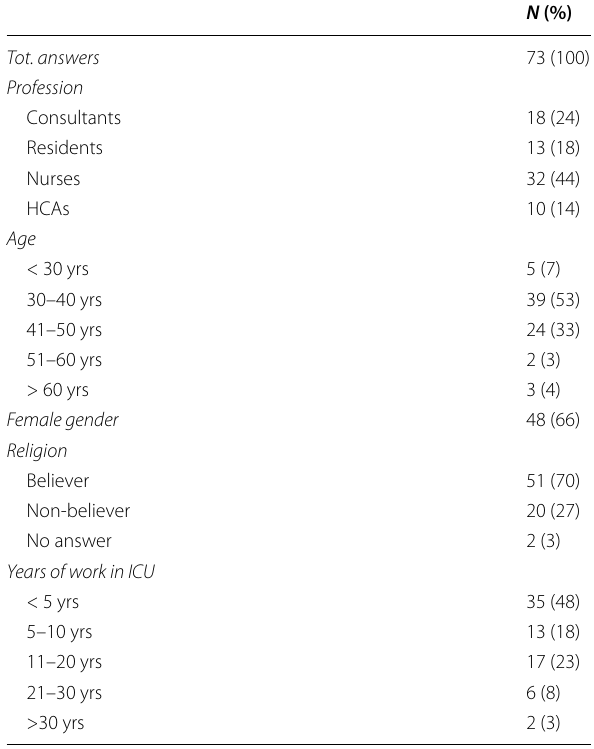
Table 1 Sociodemographic and professional characteristics of respondents (questions